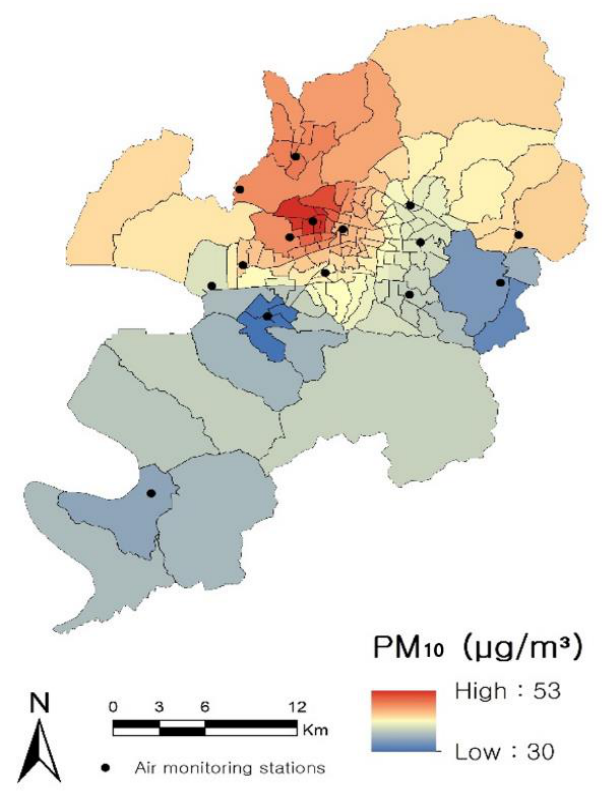
Figure 2. Spatial distribution of particulate matter PM10.